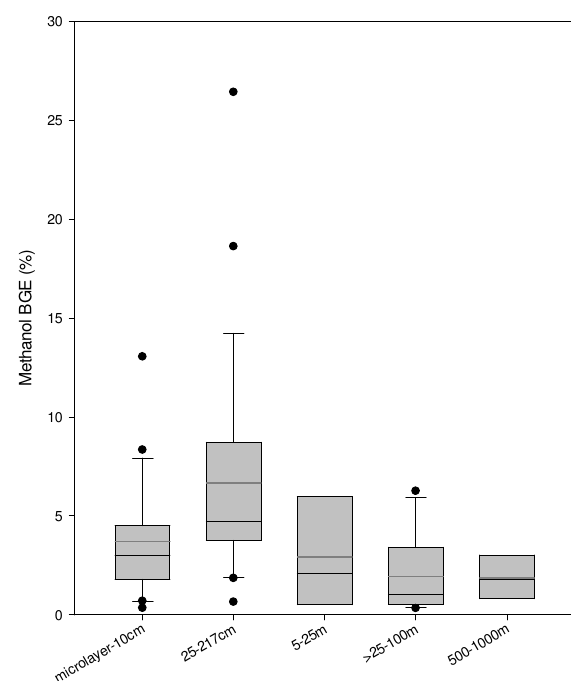
Figure 8 (cid:3)(cid:2) Fig. 8. Methanol bacterial growth efficiency with depth, where the shaded box represents the 25th and 75th percentile, the black line the mean, and the grey line the median growth efficiency. The error bars show the 10th and 90th percentile and ( • ) outlying